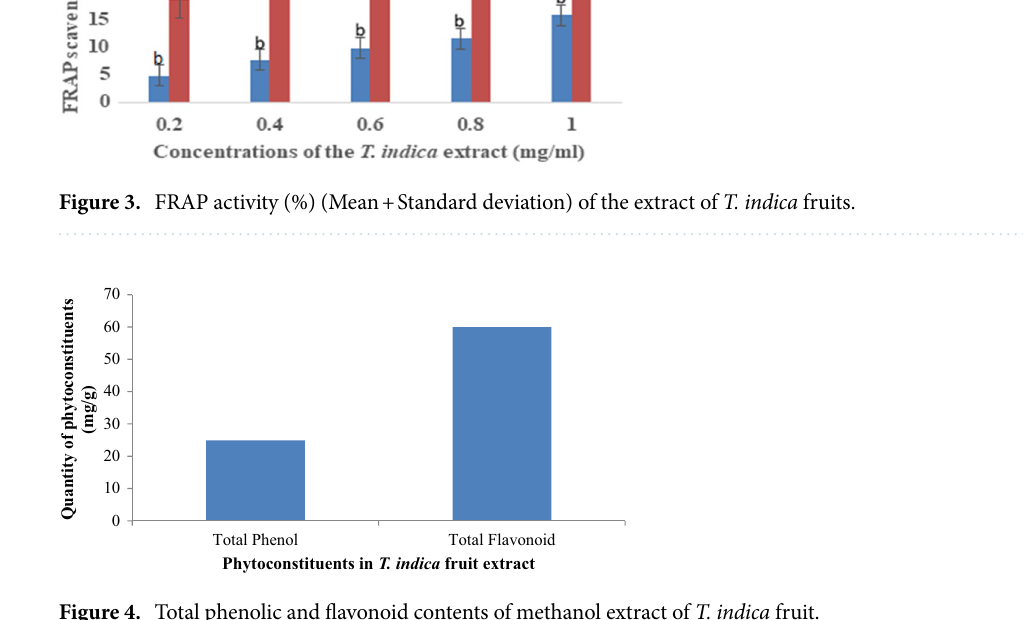
Figure 4. Total phenolic and flavonoid contents of methanol extract of T. indica